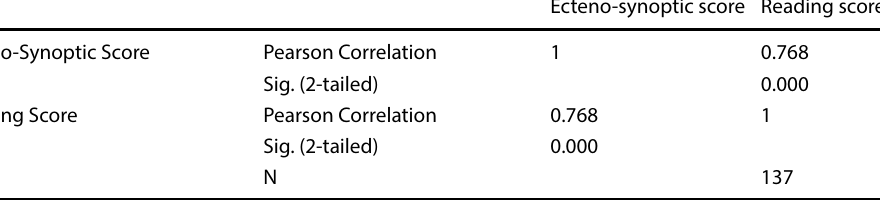
Table 2 The Correlation between All Ecteno-Synoptic Scores and Reading Scores